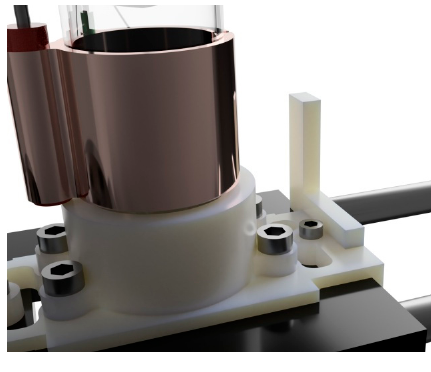
Figure 8. End-stop trigger.